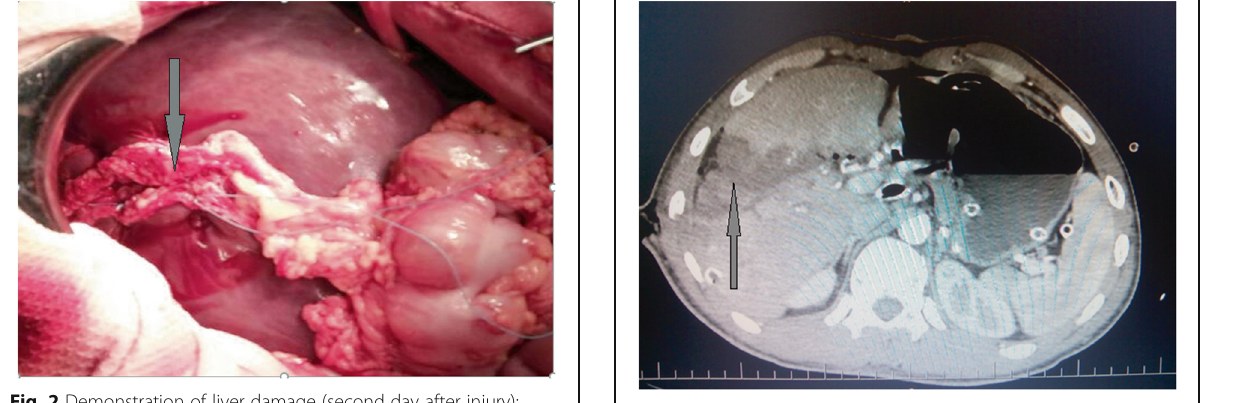
Fig. 3 Illustration of abdominal CT scan on the 14th day after injury. The zone of the irreversible ischemia of the fifth to sixth segments of the liver is marked by arrow